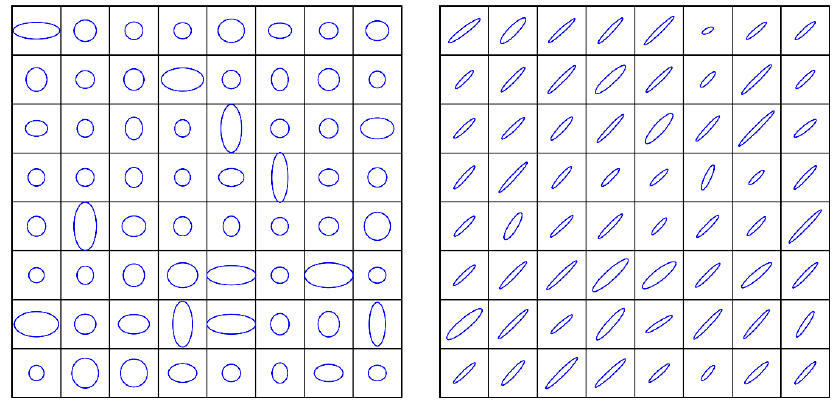
Figure 12. Reference pressure solution ( left ) and tracer concentration distribution after 2 PVI ( right ).